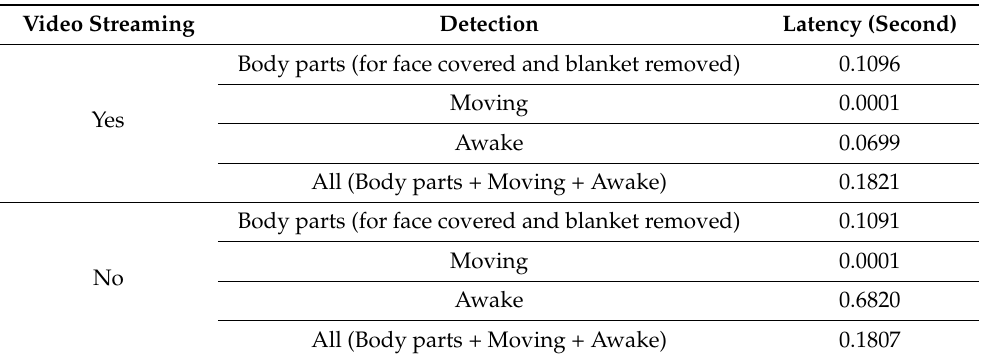
Table 1. Latency of detection algorithms on the Jetson Nano device.